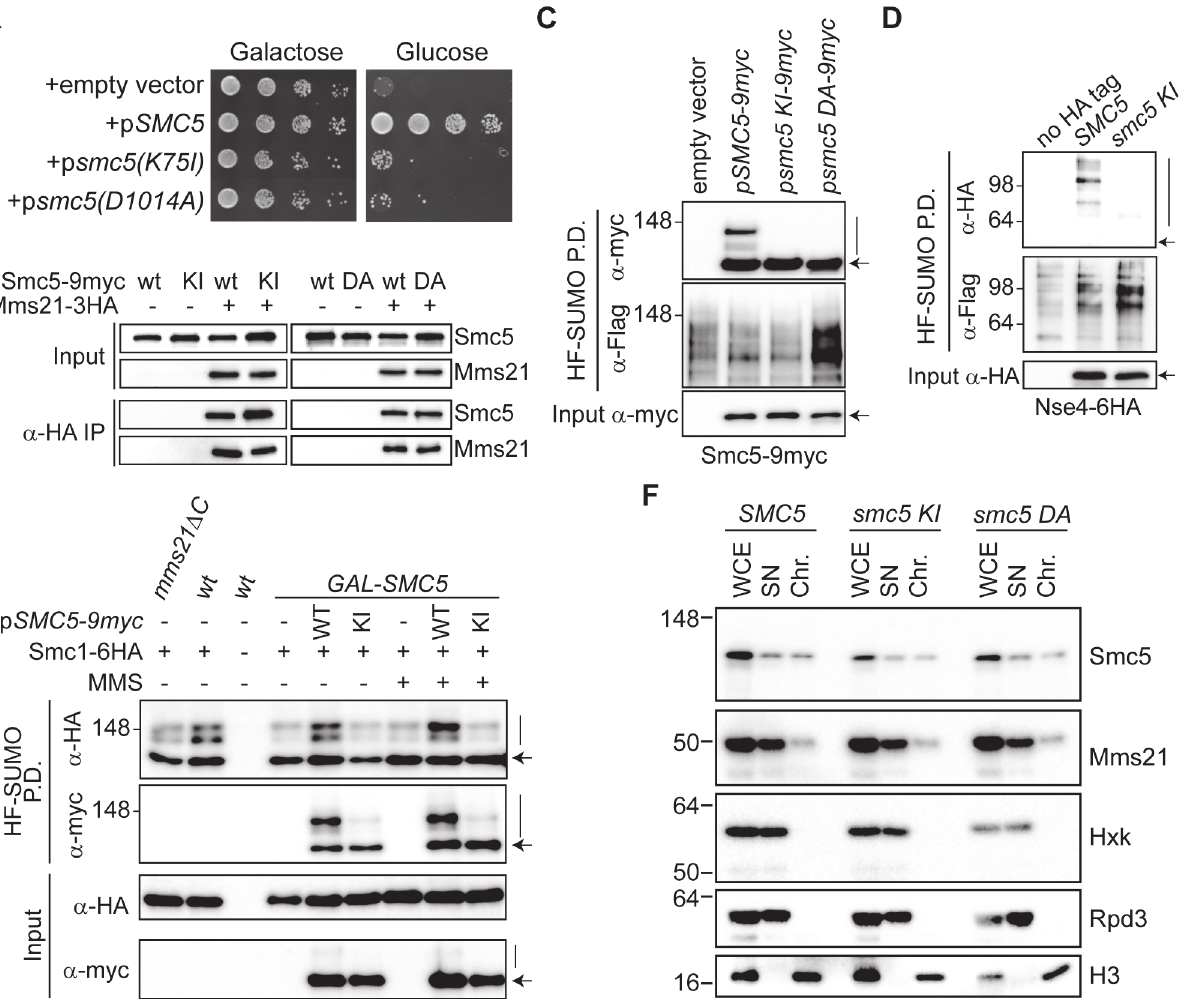
Fig 3. ATPase-dependent activity of the Mms21 SUMO ligase. A . Growth test of GALp-SMC5 cells expressing wild-type SMC5 , smc5(K75I) , or smc5 (D1014A) from a centromeric vector in plates containing galactose ( GALp ON) or glucose ( GALp OFF). B . Mms21-3HA was immunoprecipitated from exponentially growing cells transformed with the indicated SMC5 -expressing centromeric plasmids to test the Smc5-Mms21 interaction; wt = wild type; KI = smc5(K75I) ; DA = smc5(D1014A) . C . Sumoylation analysis of ATPase-defective Smc5-9myc proteins. HF-SUMO pull-down analysis in wild-type cells transformed with plasmids expressing the indicated SMC5 alleles. D . Sumoylation analysis of Nse4-6HA in smc5 ATPase mutant cells. HF-SUMO pull-down analysis in GALp-SMC5 NSE4-6HA cells expressing the indicated SMC5 alleles. Cells were shifted to glucose 6 h before collection to repress the endogenous SMC5 gene. E . Sumoylation analysis of cohesin in smc5 ATPase mutant cells. HF-SUMO pull down from cells of the indicated genotype (wt, mms21 Δ C and GALp-SMC5 ), carrying a C-terminal 6HA tag on SMC1 , and expressing or not an ectopic copy of SMC5-9myc (WT) or smc5(K75I)-9myc (KI) allele; where indicated, cells were treated with MMS 0,02% for 1 h (MMS) before collection. F . Chromatin fractionation assay from GALp-SMC5 MMS21-6HA cells expressing an ectopic 9myc-tagged copy of the indicated SMC5 alleles, collected 6 h after shift to glucose to deplete the endogenous Smc5 protein. Controls for a chromatin-bound protein (histone H3), nuclear soluble (Rpd3) and cytoplasmic soluble (Hexokinase; Hxk) proteins are shown; WCE: Whole Cell Extract; SN: Supernatant; Chr: Chromatin fraction. In C – E, arrow points to unmodified Smc5, Nse4, or Smc1 proteins, and vertical bars to their sumoylated